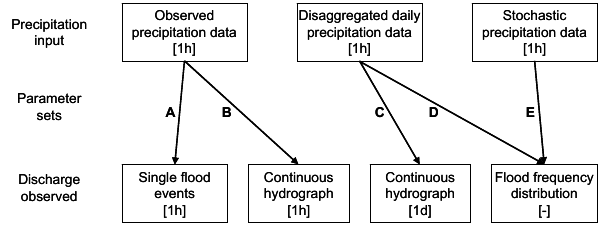
Fig. 4. Calibration strategies leading to the parameter sets A–E; the Figure 4 . Calibration strategies leading to the parameter sets A to E; the temporal resolution of temporal resolution of the data is given in the data is given in brackets